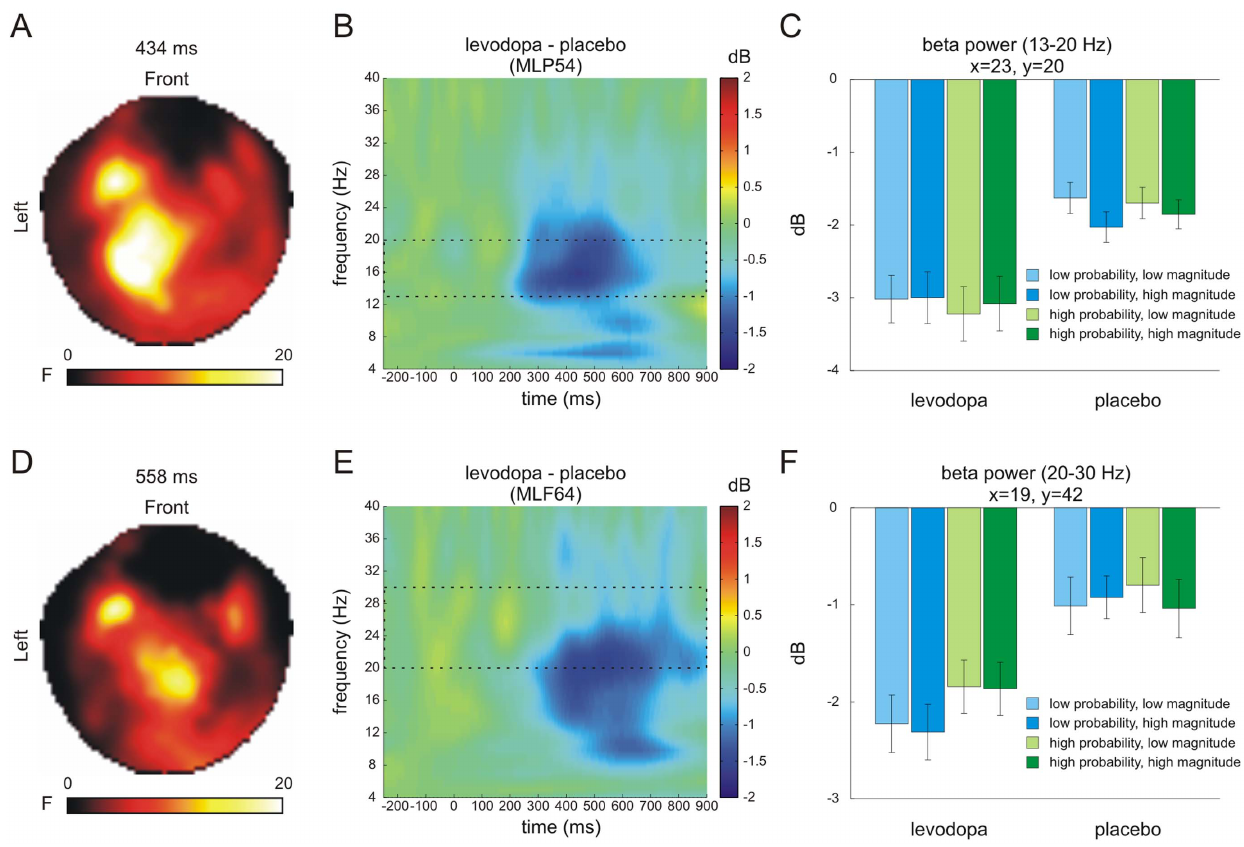
Figure 4. Time-frequency effects for reward predicting cues. SPM-based analyses across all sensors and time-points revealed main effects of drug group (levodopa, placebo) at left parietal sensors in the low beta band (peak at 434 ms; nearest sensor: MLP54) (A) and left frontal sensors for the high beta band (peak at 558 ms; nearest sensor: MLF64) following cue presentation (D). Both effects were driven by lower beta power in the levodopa group compared to the placebo group (C and F). Left columns show statistical parametric maps of the F-statistics, middle columns show the time-frequency plots as extracted from the nearest channel, and right columns show the effects for each condition at the peak time point as extracted from voxel space. Dashed boxes in B and E indicate the low (13–20 Hz) and high (20–30 Hz) beta band, respectively. Error bars in C and F denote one standard error of the mean (SEM).